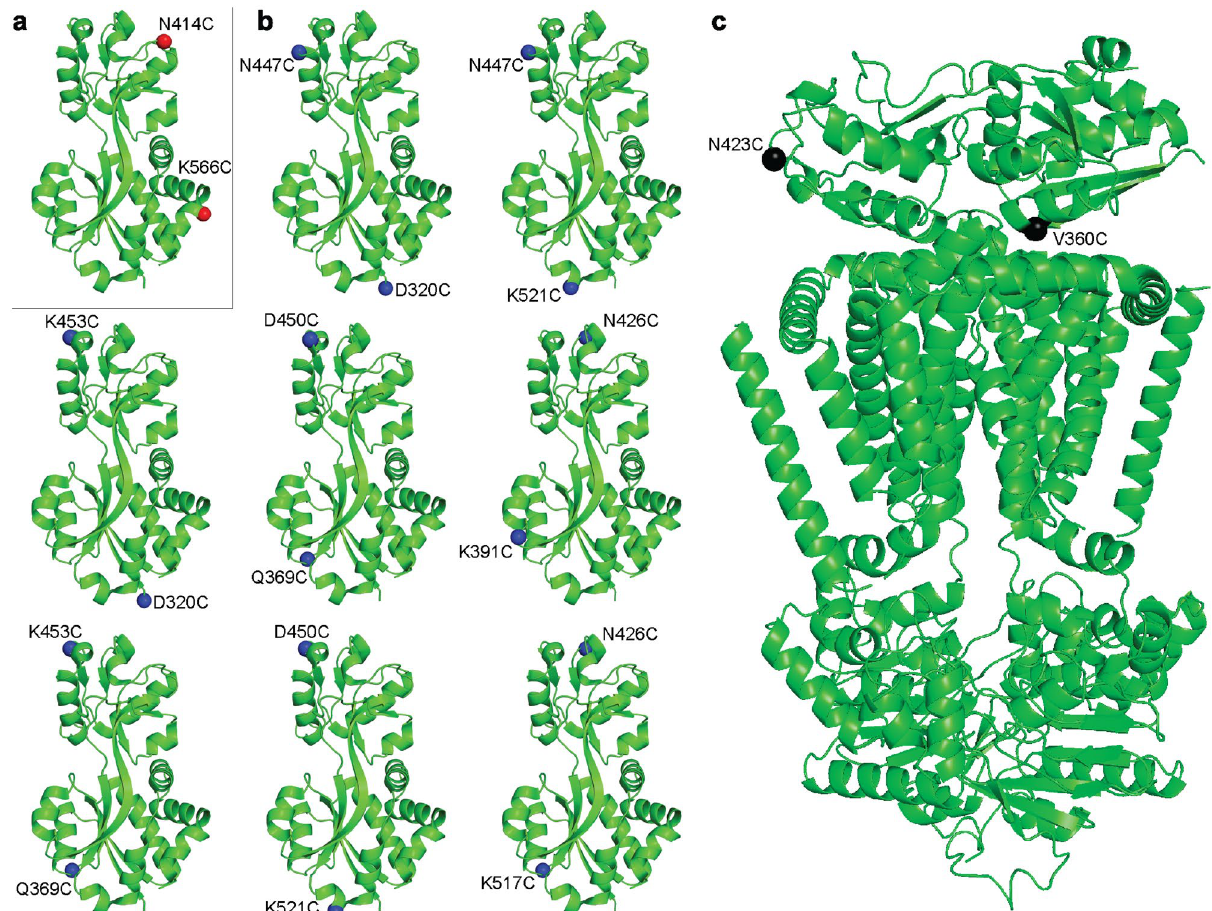
Figure 2. The 9 selected residue pairs shown in cartoon representation in OpuAC (PDB: 3L6G) (from left to right, top to bottom: N414C/K566C, D320C/N447C, N447C/K521C, D320C/K453C, Q369C/D450C, K391C/ N426C, Q369C/K453C, D450C/K521C and N426C/K517C). The location of the amino acid pairs for dye labeling are shown as spheres. ( a ) Red spheres indicate a decreasing distance upon glycine betaine binding. ( b ) Blue spheres indicate an increasing distance upon binding. ( c ) Shows the positions of the Cys residues (V360C/ N423C) previously used for labeling of OpuAC in the full-length protein (PDB: 7AHD), see Sikkema et al 19 for the full-length structure of OpuA; labeling of these residues affects the docking of the SBDs and therefore they cannot be used for smFRET studies of full-length OpuA. Residue pair Δd AB d